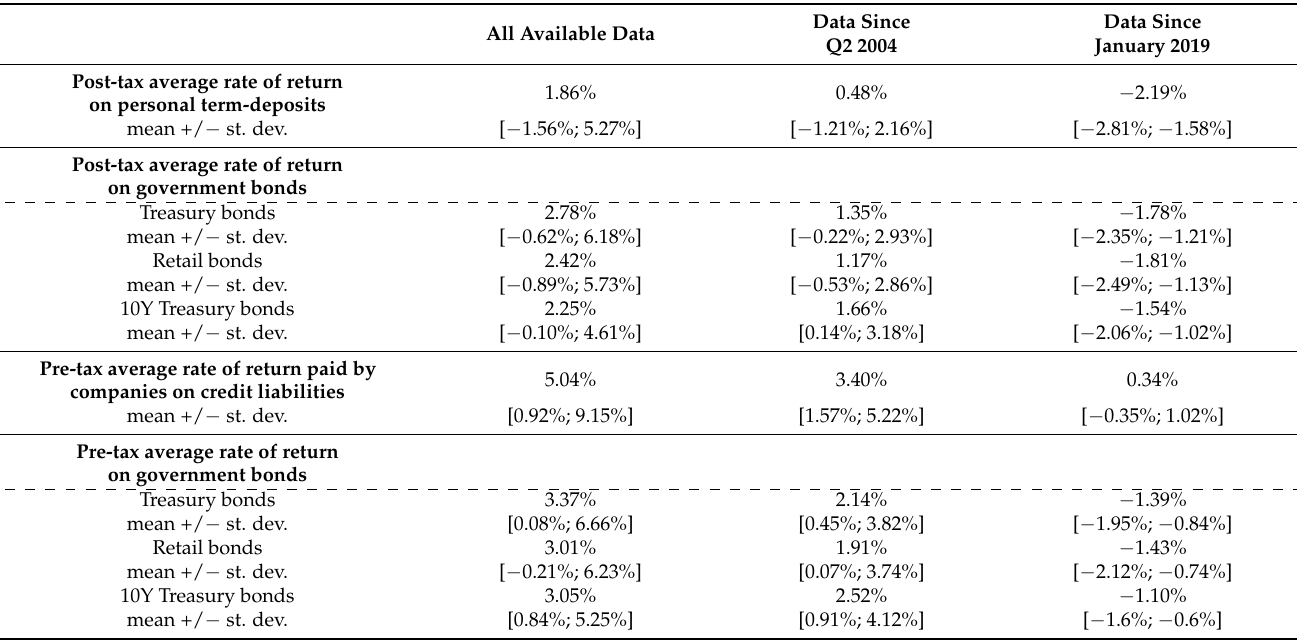
Table 1. Estimates of Social Discount Rate for Poland based on market rates.